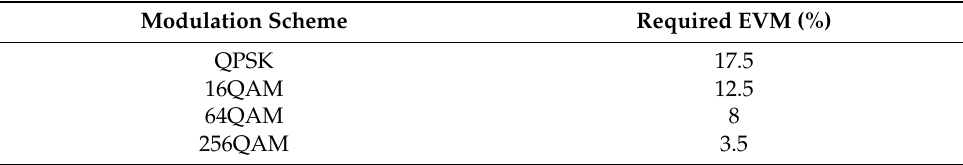
Table 1. EVM requirements for 3GPP NR carrier [17].